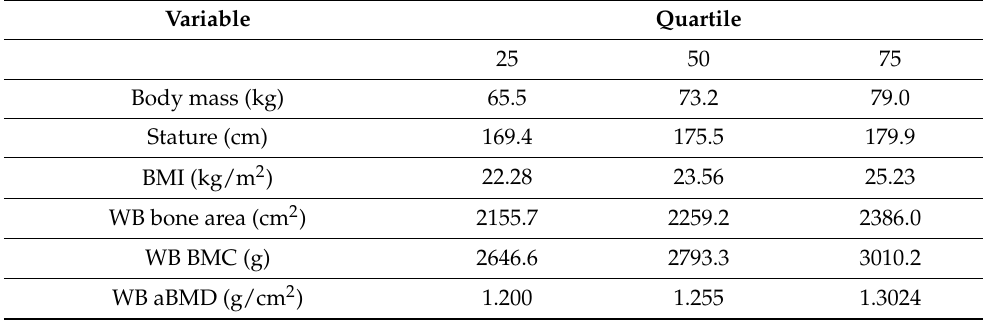
Table 5. Quartile (25th, 50th, 75th) values for the body composition of male